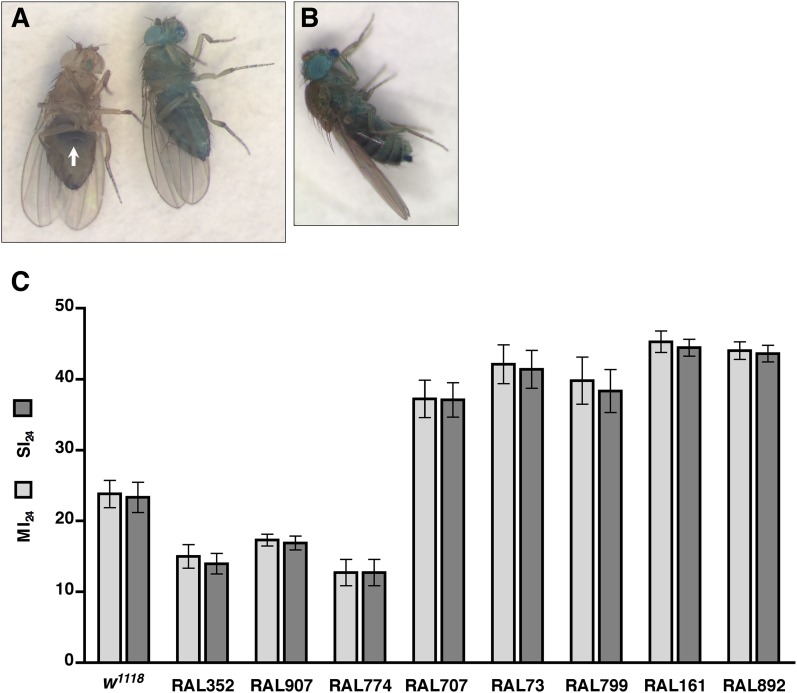
Traumatic injury causes intestinal barrier dysfunction.(A) Flies that were fed molasses food with blue dye. In flies without traumatic injury (left), the dye was confined to the gut (arrow). In some flies with traumatic injury (right), the dye leaked out of the intestine into the hemolymph and dispersed throughout the body, producing a ‘Smurf’ phenotype (Rera et al., 2011; Rera et al., 2012). (B) A fly that was fed molasses food with blue dye and received brain injury from head compression. (C) Average and SEM of the MI24 (light gray bars) and SI24 (dark gray bars) for the indicated fly lines. The MI24 and SI24 were not significantly different for any of the fly lines (p > 0.32, one-tailed t test). The correlation coefficient (r) between the MI24 and SI24 was 1.0.